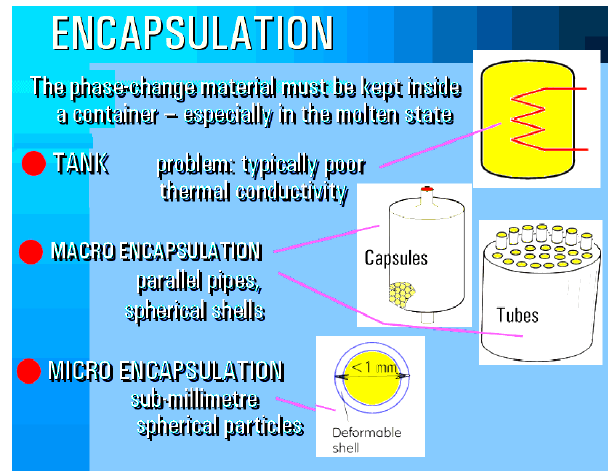
Fig. 11. Especially during the melting process – and, of course, also later when the phase changing material is in the molten state – it is necessary to keep this material within a suitable container preventing the escape. There are three basic